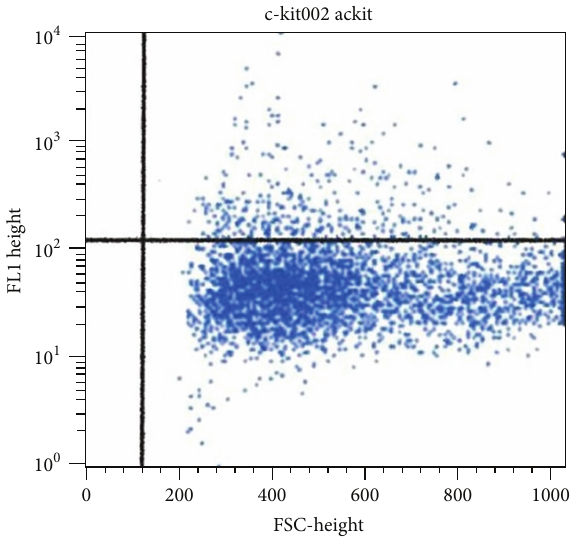
Figure 2: The dot plot of CD117-immunopositive MCT cells in this case was drawn back by the software. The MCT cells were gated electronically and were harvested from the cells presenting above the baseline, at the quadrant II (upper-right) of dot